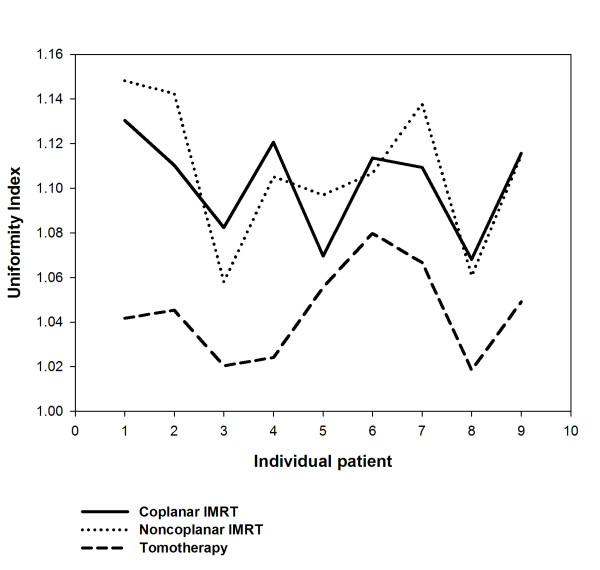
The uniformity index (UI) for each individual patient undergoing coplanar intensity-modulated radiotherapy (IMRT), noncoplanar IMRT, and helical tomotherapy.